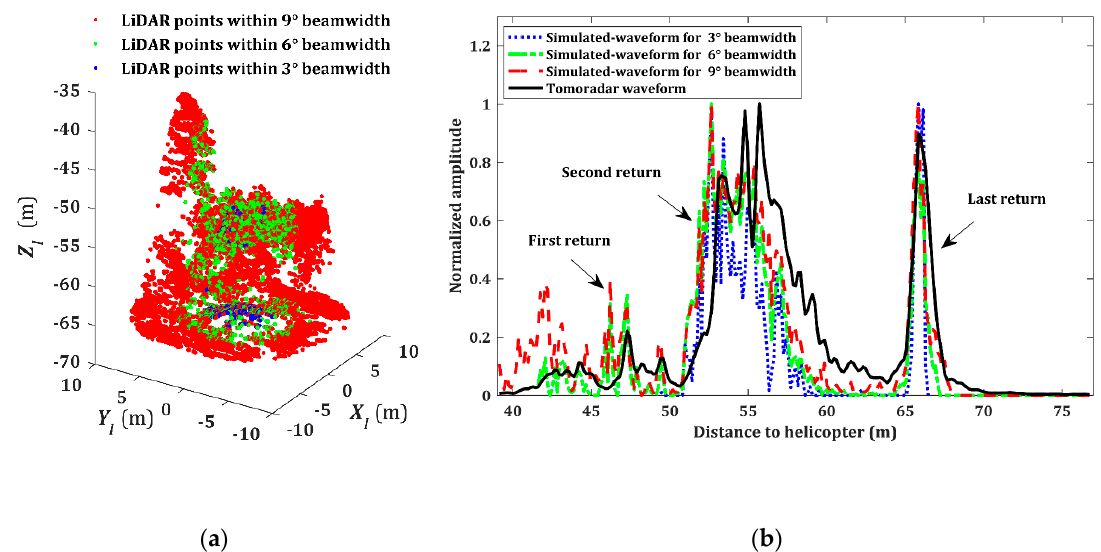
Figure 7. The lidar points and comparison between Tomoradar waveform and simulated-waveforms within Tomoradar cone of 3°, 6°, and 9° for the 6700th Tomoradar measurement. ( a ) The original lidar point. ( b ) Tomoradar waveform and simulated-waveforms. The amplitudes of all waveforms are normalized with the corresponding maximums and described with different colors, respectively.